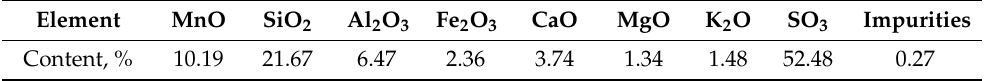
Table 4. Elemental composition of ore before and after contact with hydrogen sulfide. Element Mg Mass Content Before Sorption, % Mass Content After Sorption, % According to the results of X-ray phase analysis of ore samples, after contact with gas, there are no crystalline sulfur-containing phases, while along with quartz hydrated silicate Н 2 Si 2 O 5 and iron (III) oxide, a new phase MnO (OH) appears, which is a hydrated form of manganese (III) oxide Mn 2 O 3 2H 2 O. Т akanelite (Mn,Ca)Mn 4 O 9 × 3H 2 O was not found in the ore (Figure 7).